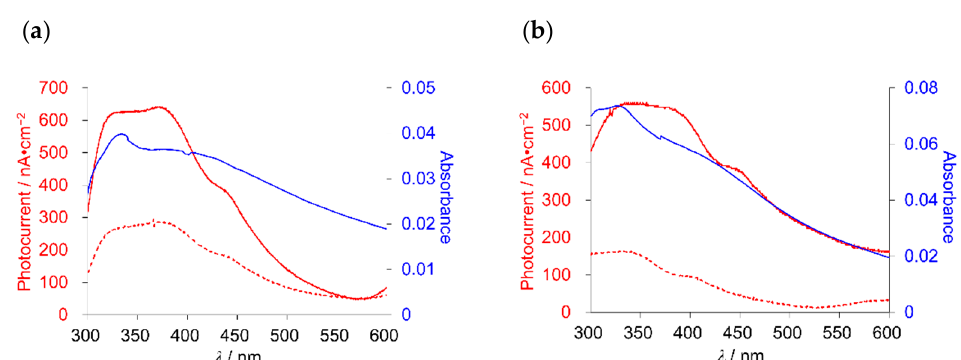
Figure 3. Photocurrent action spectra under the bias voltage vs. Ag/AgCl reference electrode (red solid line: − 0.2 V, red dashed line: 0 V vs. Ag/AgCl) and absorption spectra (blue line) of the thin film samples of ( a ) Zn complex 1 and ( b ) Ni complex 2 prepared by a casting method on the ITO electrodes.